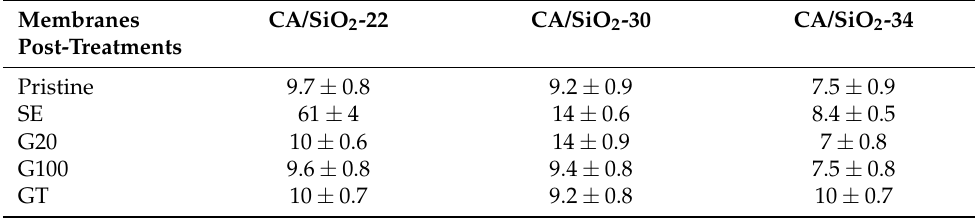
Table 2. Correlation times τ c (ns) for the molecular rotational diffusion motion. Membranes CA/SiO 2